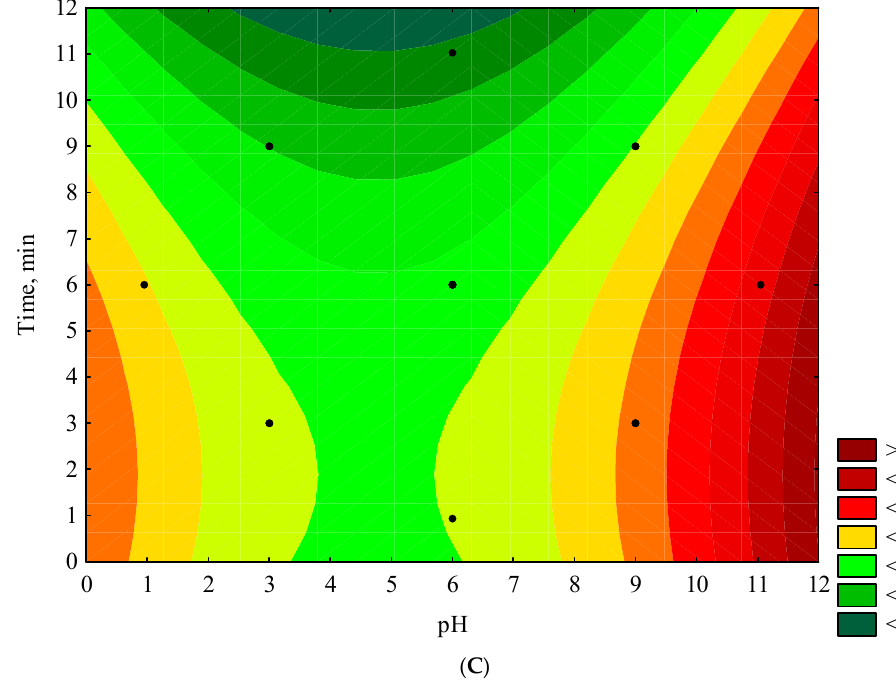
Figure 3. Response surface plots for COD (g O 2 /L) with respect to K 2 FeO 4 (g/L) and pH ( A ), time (min), and K 2 FeO 4 (g/L) ( B ) and time (min) and pH ( C ).